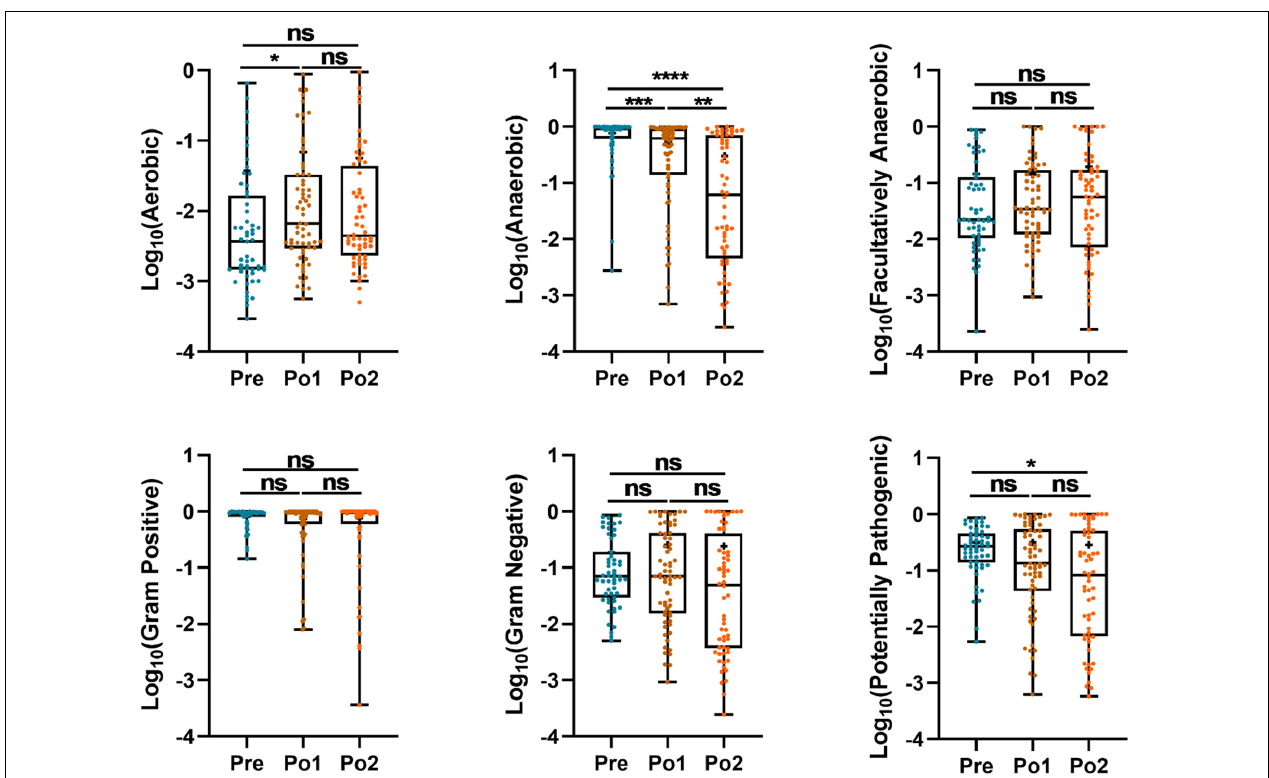
FIGURE 5 | Perioperatively BugBase analysis based on 16S rRNA gene sequencing of cohorts. Outcome was grouped according to time ( x -axis). Logarithm of relative abundance with 10 as base is presented on y-axis. Statistical assessment was carried out with Kruskal–Wallis test followed by post hoc test using Dunn’s multiple comparison test. P < 0.05 indicates statistical significance (* P < 0.05, ** P < 0.01, *** P < 0.001, and **** P < 0.0001), and ns means P > 0.05. Results are expressed as median and quartile.